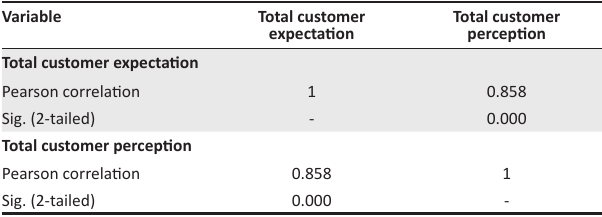
FIGURE 3: Average perceptions and expectations of Gautrain users during TABLE 2: Pearson correlation.